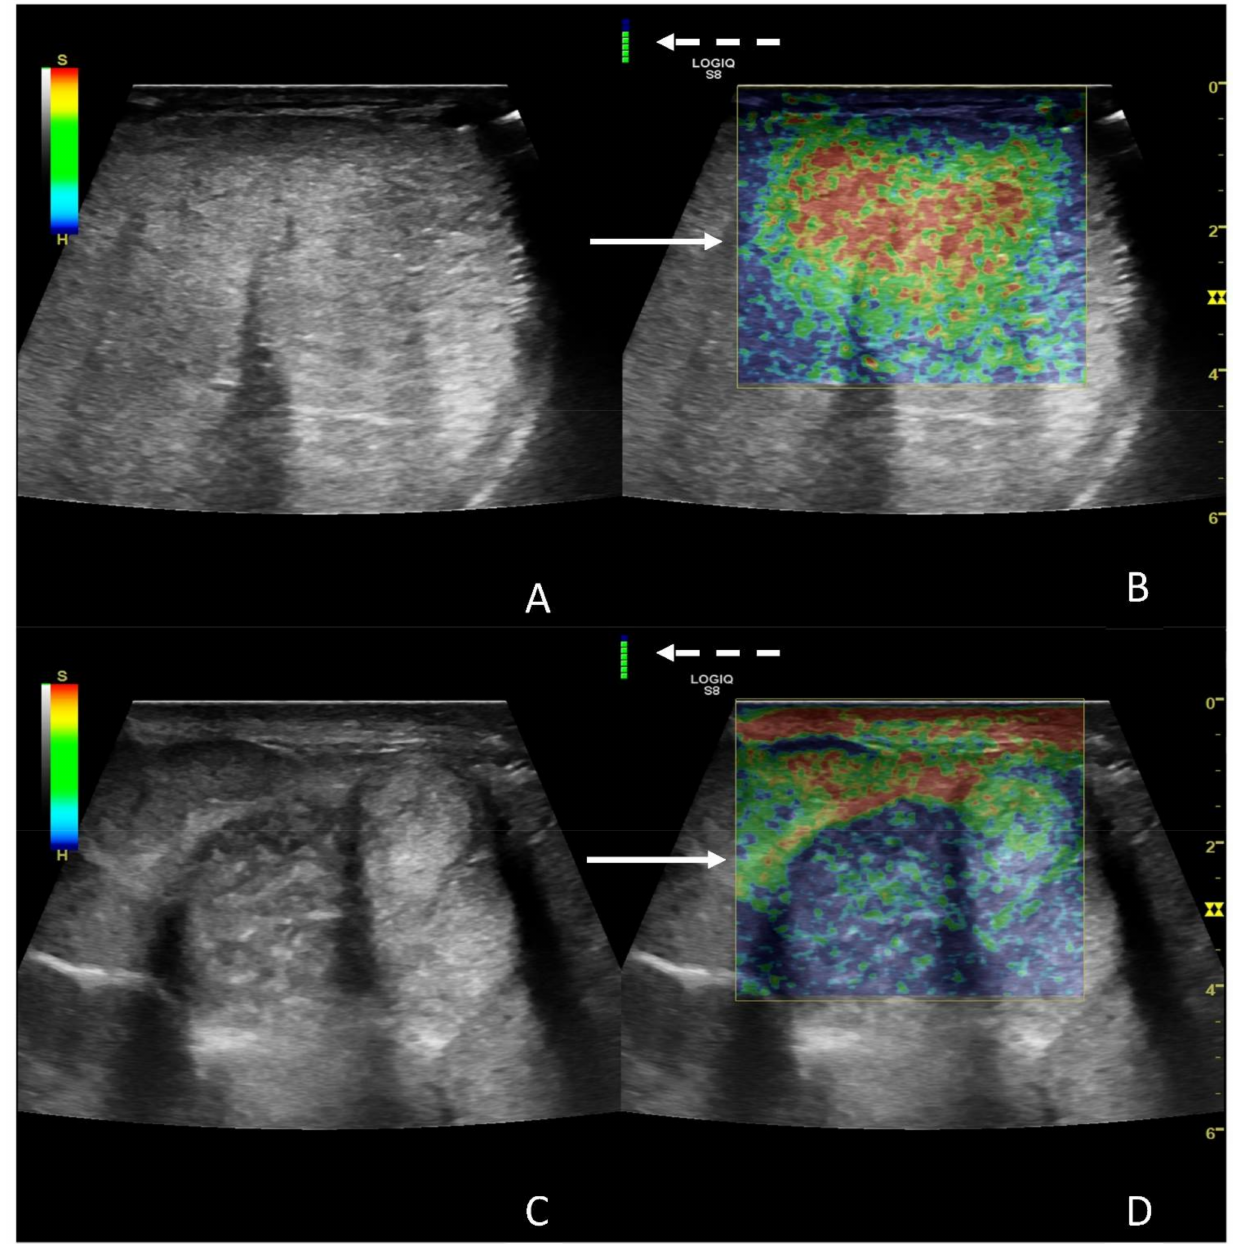
Figure 5. Images from SE of a normal ( A , B ) and a diseased testicle ( C , D ). In panel A and B, the B-mode image and the elastogram are presented, respectively; in the elastogram, notice the color distribution, characterized by central parenchymal red-green color with blue edges (white solid arrow). In panels C and D, B-mode image and elastogram are presented as well, with the elastogram characterized by an heterogenous pattern, mostly blue with a central small green areas (score 5—white solid arrow). The white dotted arrows point at a color bar is indicative of the quality of examination, which is considered good if it appears